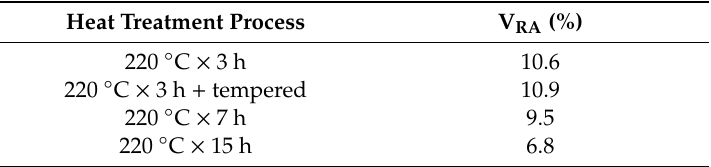
Figure 5. XRD patterns of the experimental steel after different heat treatment process. Table 1. The volume fractions of retained austenite in samples subjected to different heat treatment process (V AR %).